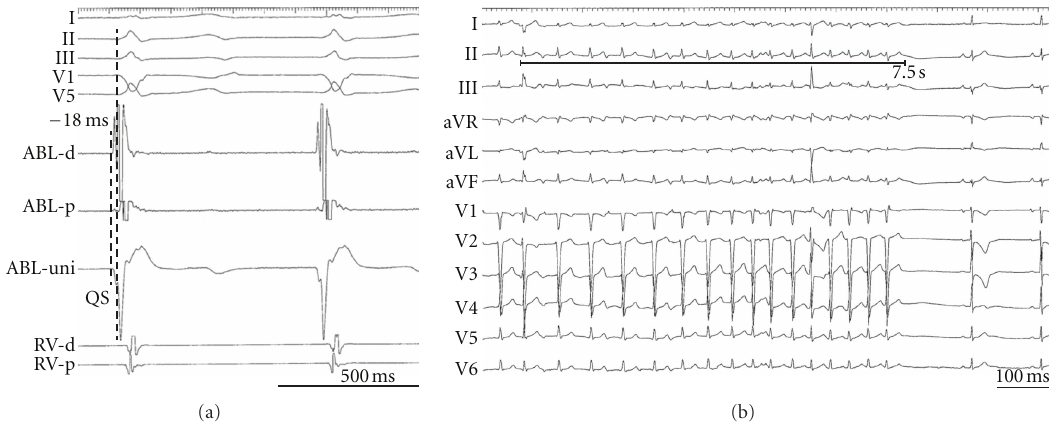
Figure 3: (a) The local contact bipolar and unipolar electrograms at the ablation site during AIVR. In the bipolar recording, the potential preceded the surface QRS wave by 18ms. The unipolar recording exhibited a QS pattern. (b) The intracardiac electrogram during the RF delivery. The RF current interrupted the